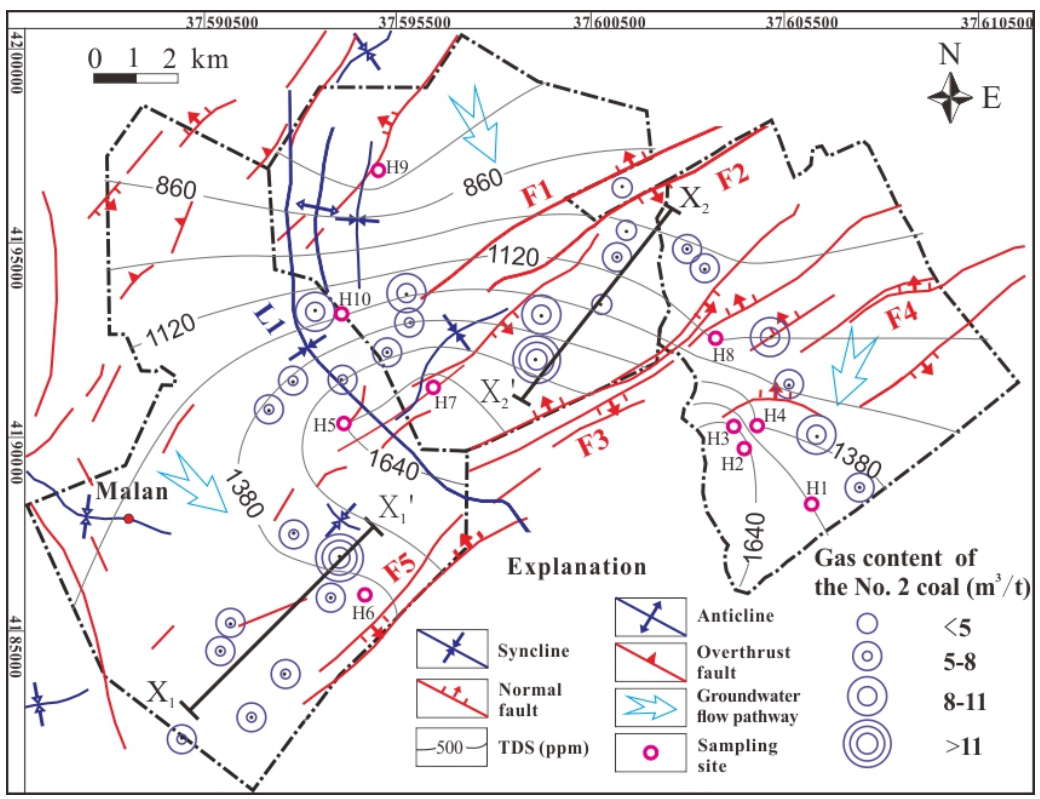
Figure 11. Total dissolved solids (TDS) of groundwater associated with the gas content of the No. 2 coal seam in the Gujiao area (TDS refers to [29]), Lines X 1 –X 1 ’ and X 2 –X 2 ’ are the hydrodynamics profiles.